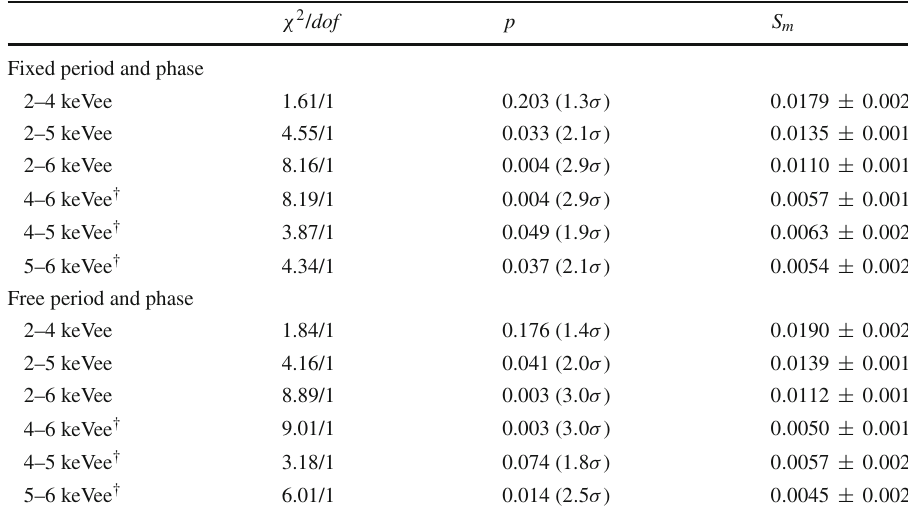
from Figure 3 of Ref. [11] and exposures are taken from Refs. [8,11]. The mean time for each cycle is given relative to January 1, 1995,